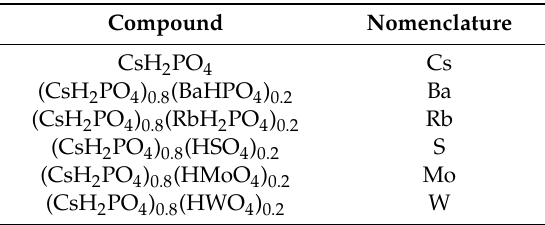
Table 1. Nomenclature for the compounds based on the solid solutions (CsH 2 PO 4 ) 0.8 (A n H 3- n PO 4 ) 0.2 and (CsH 2 PO 4 ) 0.8 (HBO 4 ) 0.2